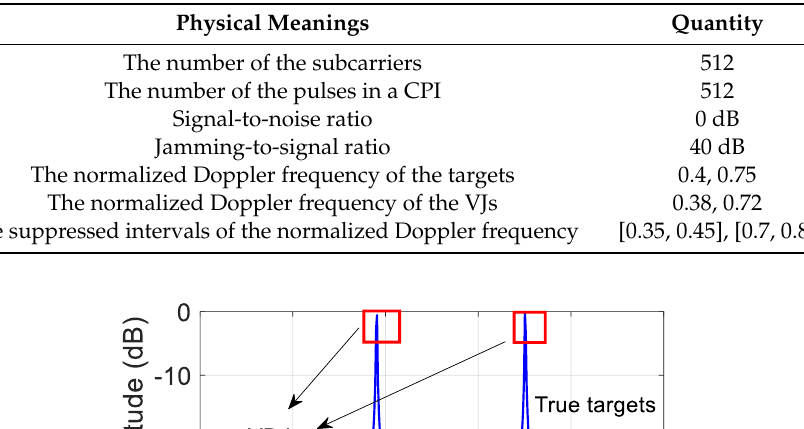
Table 1. Simulation Parameters for Suppressing VDJ.